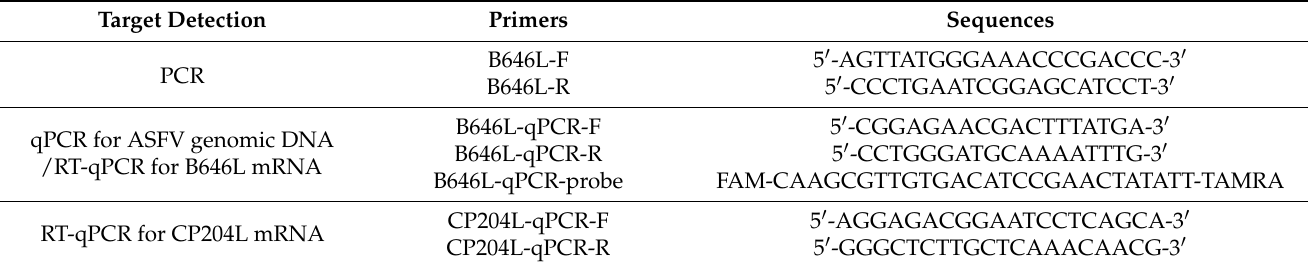
Table 2. Primers used for ASFV